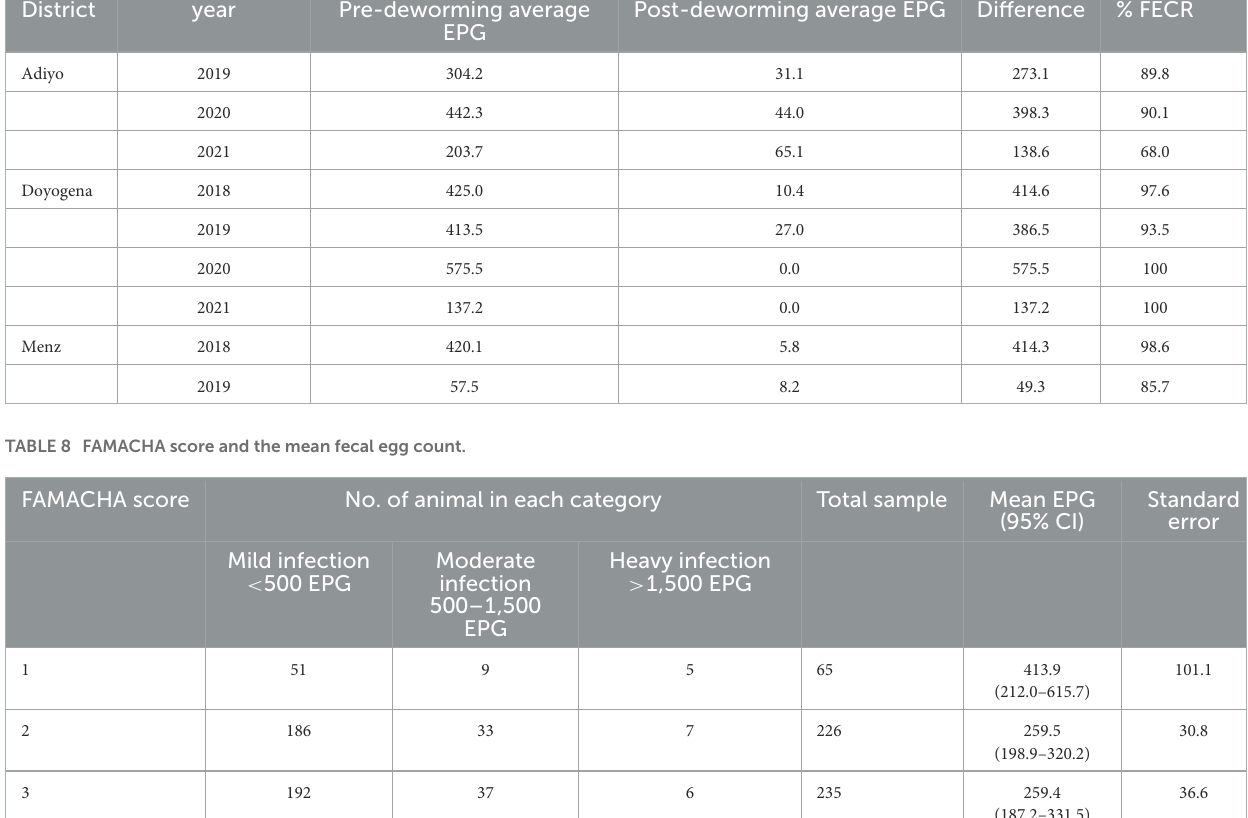
TABLE 7 Pre- and post-deworming ovine GIT parasite average EPG count and percentage of FECR by district and year. District